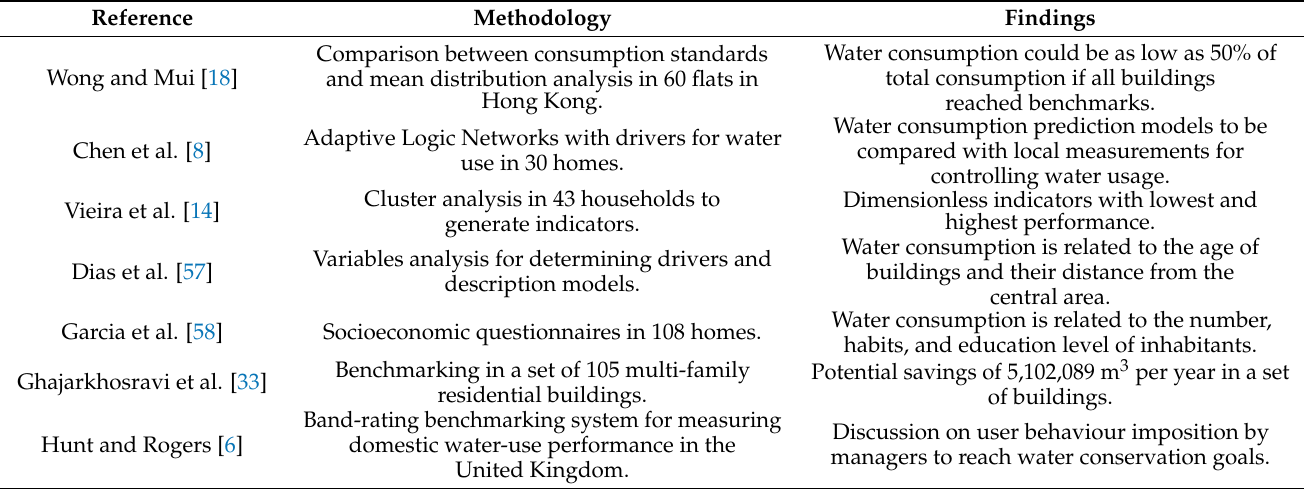
Table 2. Procedures and results related to benchmarking water use in residential